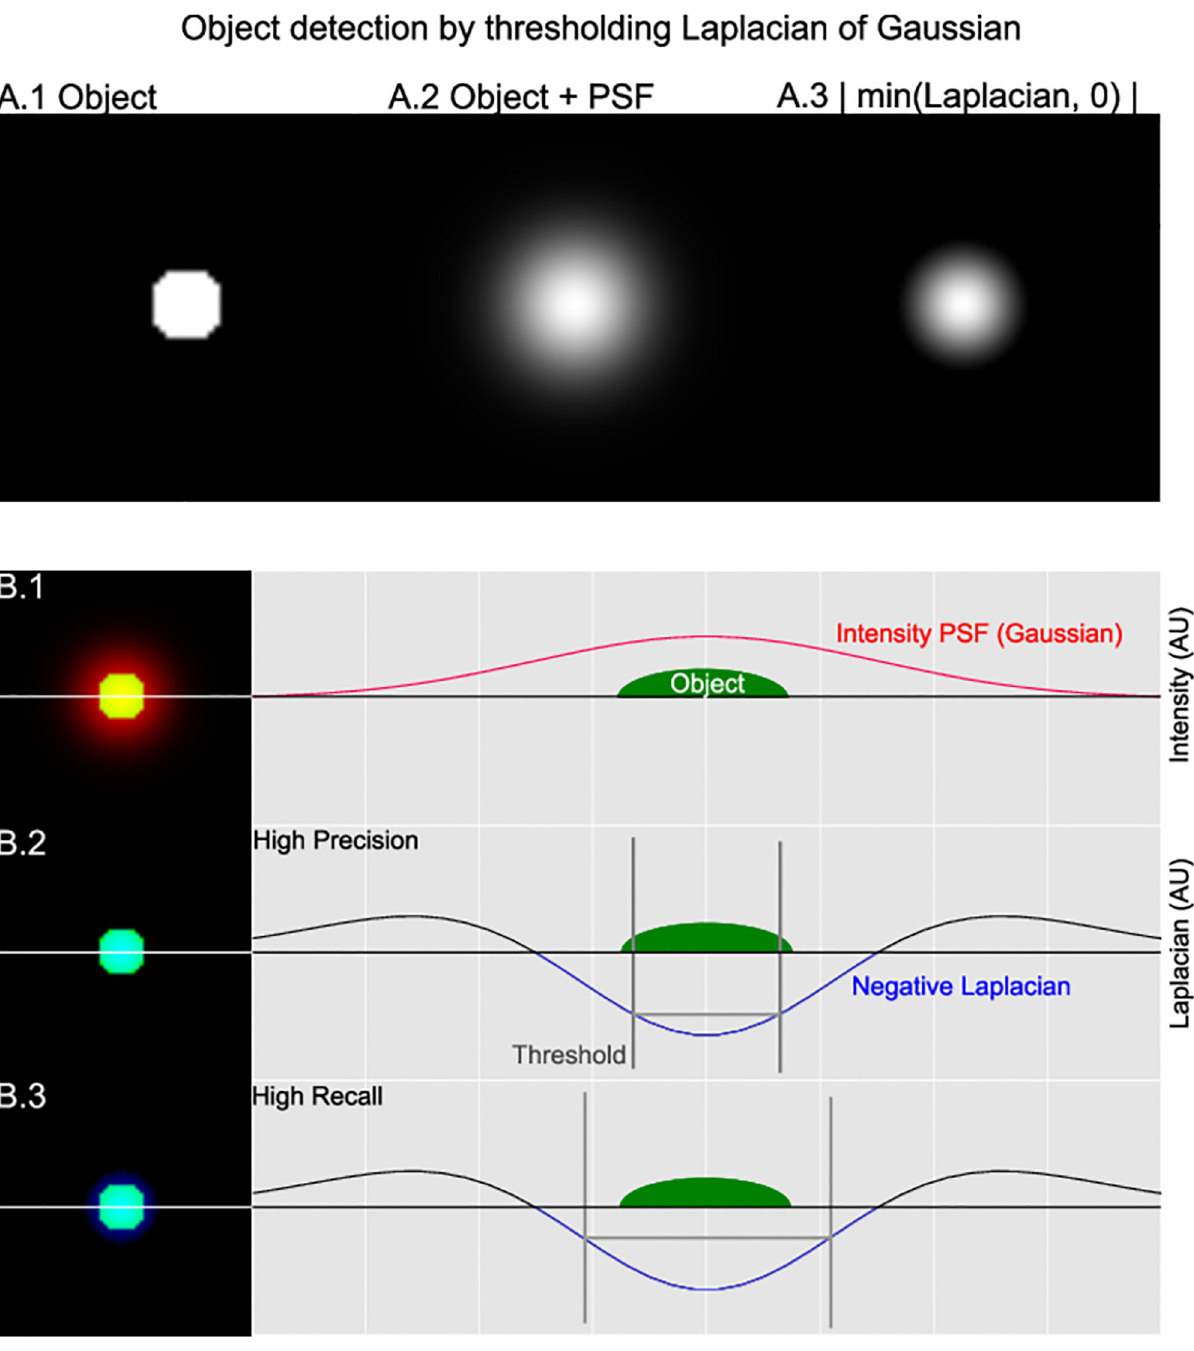
Fig 2. Object detection principle. The negative Laplacian (A.3-V, B.1)) can be leveraged to detect Gaussian 2D observations of 3D fluorescent objects. Thresholding V is a balance between high precision (B.2) and high recall (B.3)